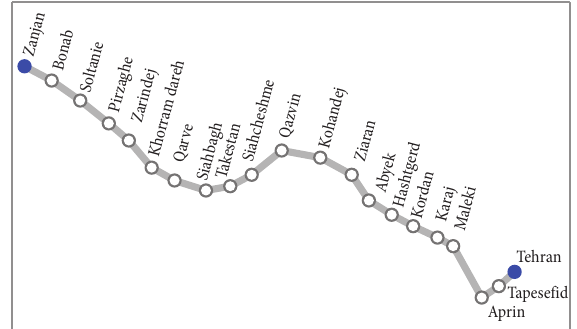
Fig. 2. Tehran–Zanjan route in